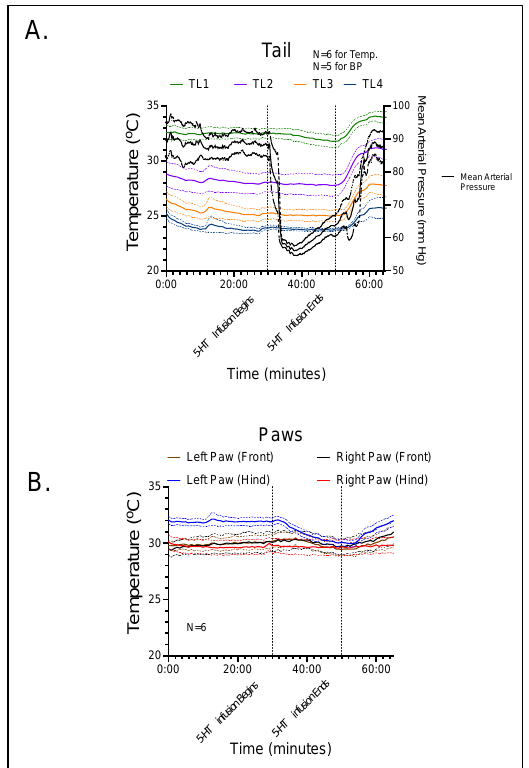
Figure 2. ( A ) Blood pressure and thermographic data for segments of the rat tail during the course of the experiment. ( B ) Thermographic data for the four paws of the rat during the course of the experiment. Lines represent means with shaded area the standard deviation for the number of rats reported. During 5-HT infusion, temperature of the tail did not increase significantly in the paws or any segment of the tail when compared to baseline. This suggests that an increase in blood flow in the thermoregulatory cutaneous vasculature does not occur during 5-HT- induced hypotension in the rat. However, the stable cutaneous blood flow during the rapid and large decrease in blood pressure caused by 5-HT indicates that vascular re- sistance in the cutaneous bed was dramatically decreased. Interestingly, cessation of 5-HT infusion was associated with a statistically significant increase in temperature in all tail segments (TL1, TL2, TL3 and TL4) and a modest increase in the paws as well.